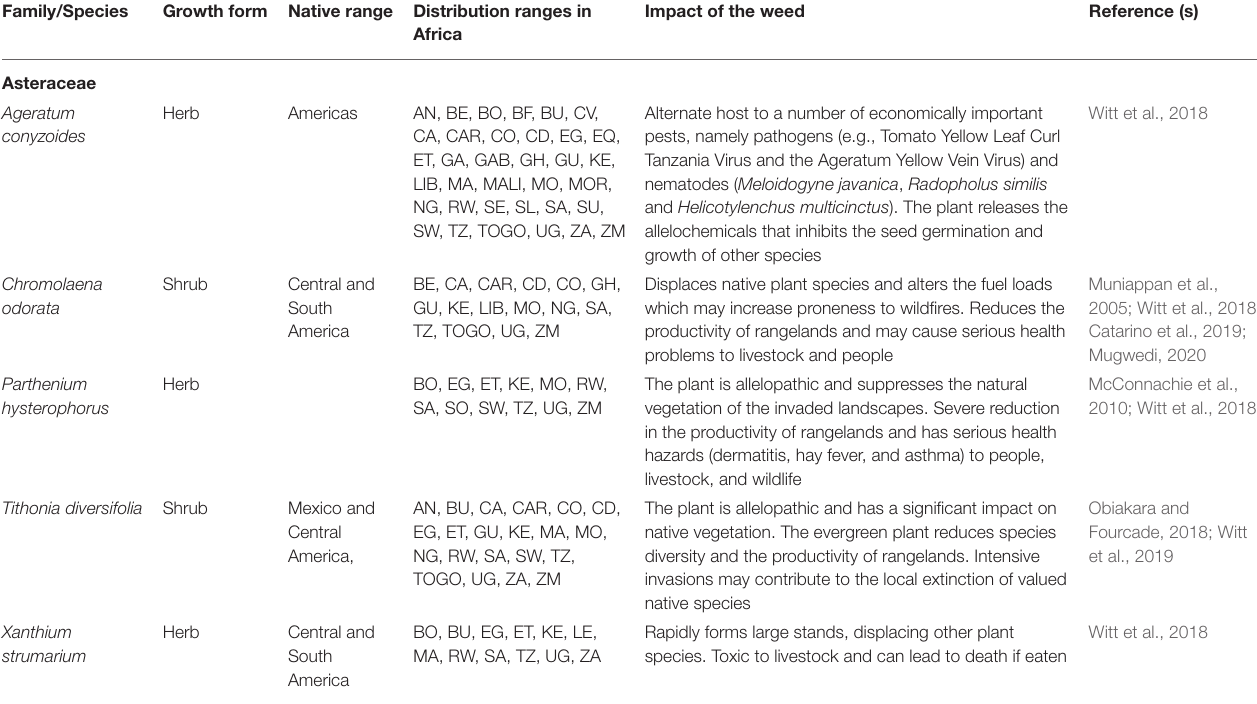
TABLE 1B | Published reports on the impact of some invasive alien plants in sub-Saharan